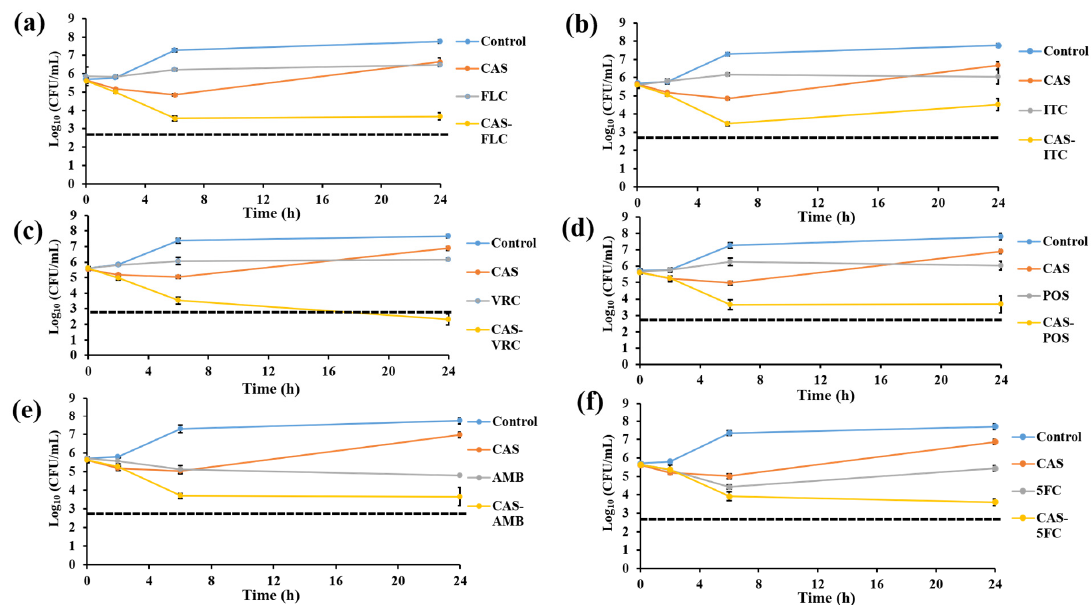
Figure 2. In vitro activities of CAS (4 µ g/mL) in combination with FLC 25 µ g/mL; ( a ), ITC (4 µ g/mL; ( b ), VRC (1 µ g/mL; ( c ), POS 4 µ g/mL; ( d ), AMB 1 µ g/mL; ( e ), and 5FC 0.1 µ g/mL; ( f ) against C. glabrata IFM60089 as determined by the time-killing assay. The detection limit was 20 CFU/mL. Dashed lines represent a >99.9% growth reduction compared with the initial inoculum size for determination of fungicidal activity. CAS-FLC, CAS-VRC, and CAS-POS combinations showed synergetic activities, with only CAS-VRC combination showed fungicidal activity. Each data point represents the means ± standard deviation of results from two independent experiments.